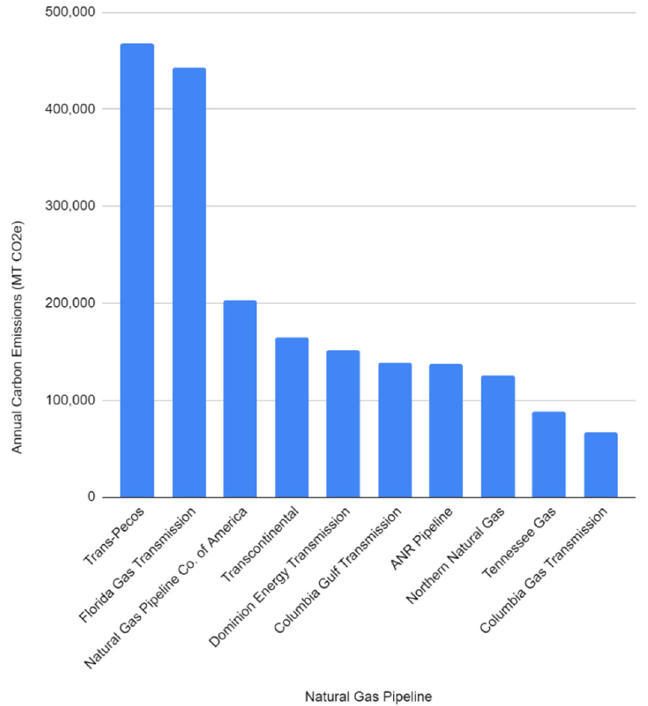
Figure 8. Top CO 2 Emission Point-Sources of the Natural Gas Industry for Transport.